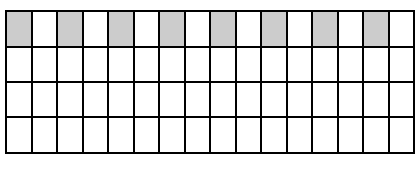
Figure 4: Locations where ι adds the round constant.